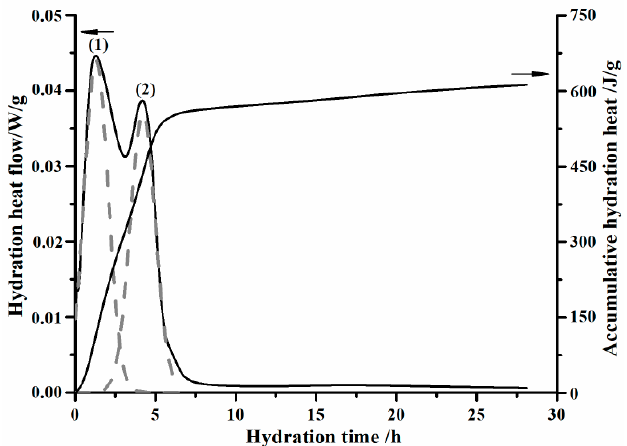
Figure 2. Hydration heat flow and accumulative hydration heat curves of synthesized C 12 A 7 over hydration time.